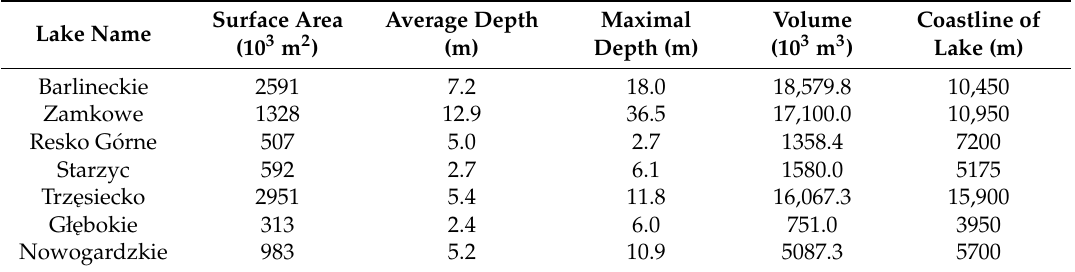
Table 1. Basic morphometric parameters of the analysed